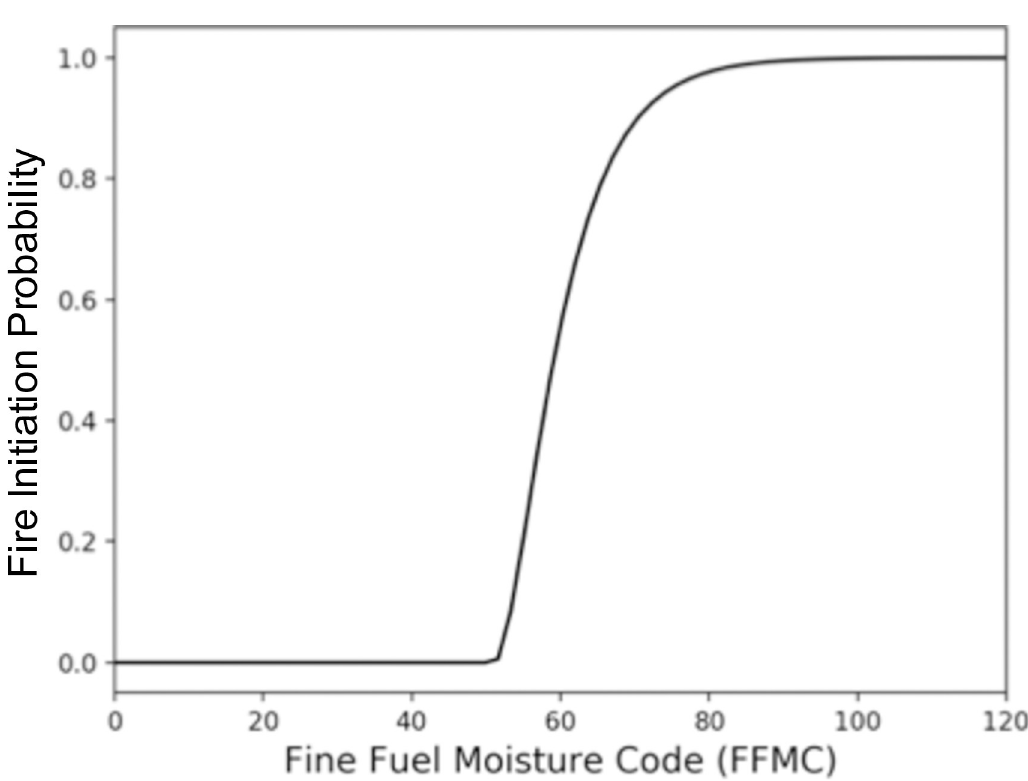
Fig 2. Example fire initiation probability curve. This example is for a vegetation type with a fine fuel moisture code (FFMC) threshold of 86, an FFMC and buildup index (BUI) minimum threshold fraction of 0.6 and an FFMC maximum threshold fraction of